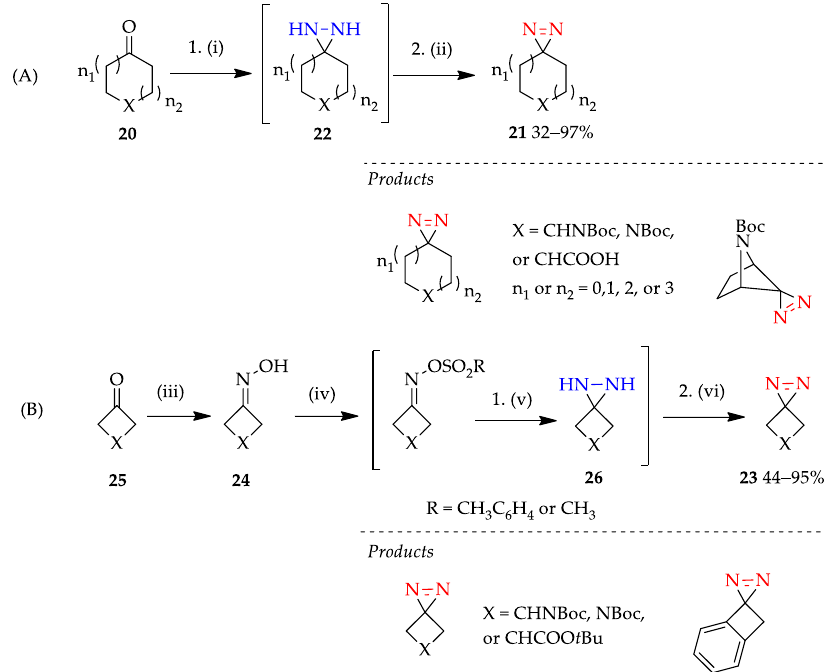
Figure 5. Diaziridine-mediated functionalized spirocyclic 3 H -diazirine synthesis. ( A ) Five- to seven-membered heterocycle or bicycle ketone 20 as starting material. ( B ) Four-membered heterocycle ketone 25 as starting material. Reagents: (i) NH 3 -MeOH then NH 2 OSO 3 H, (ii) I 2 -Et 3 N, (iii) NH 2 OH·HCl and MeOH, (iv) Mesyl chloride or tosyl chloride and Et 3 N, (v) NH 3 , (vi) I 2 and NaHCO 3 .